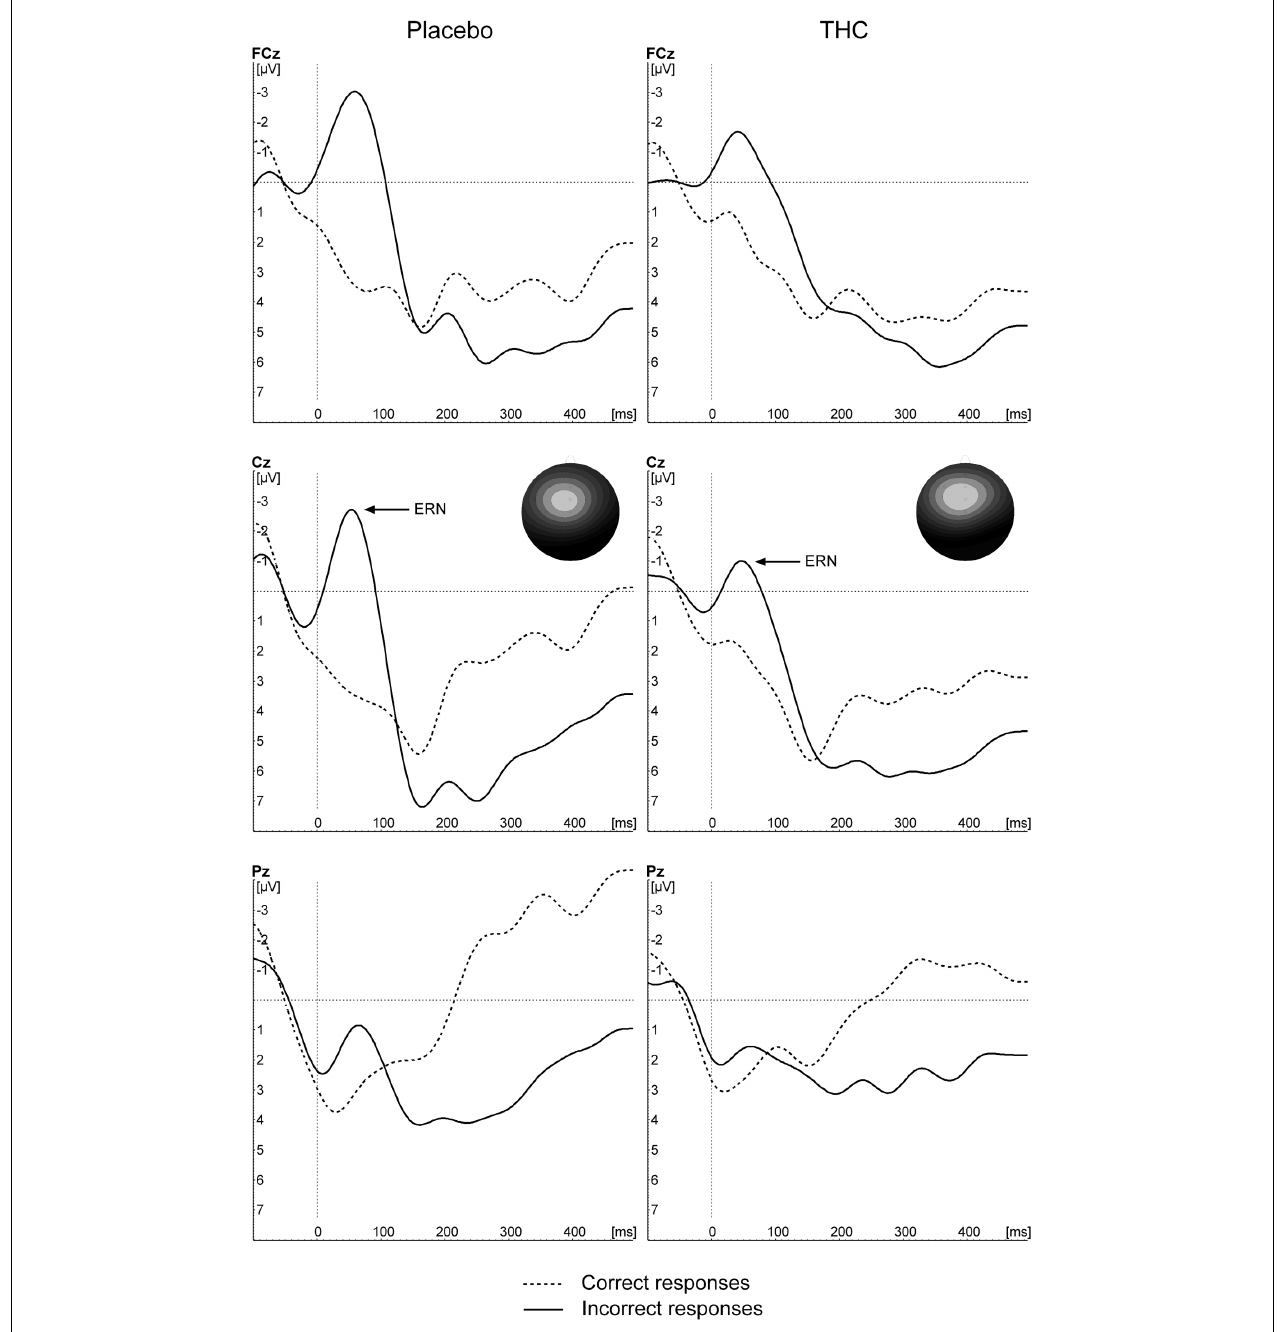
FIGURE 2 | Grand average waveforms of incorrect and correct responses to incongruent trial types for placebo andTHC